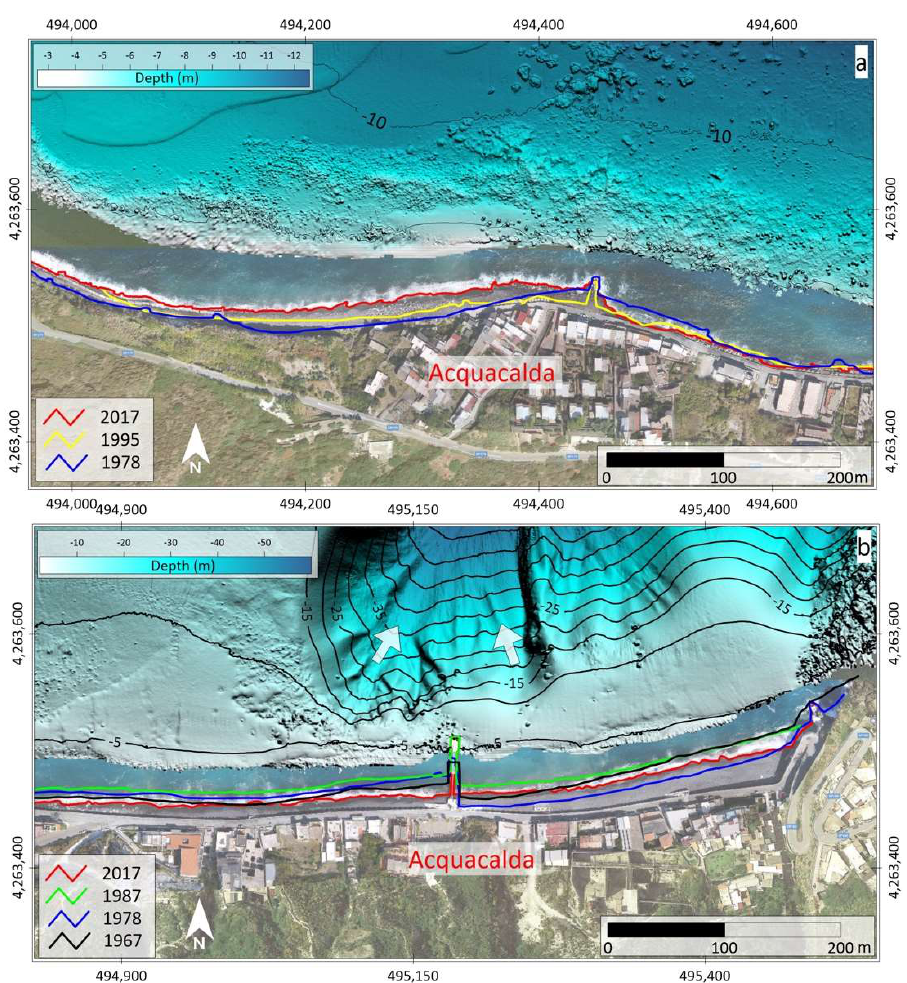
Figure 5. Map of Acquacalda sector, with zoomed areas in the western ( a ) and eastern ( b ) part of the beach and selected shorelines. See Figure 1 for location of both maps. White arrows show the active canyon heads located in the nearshore.